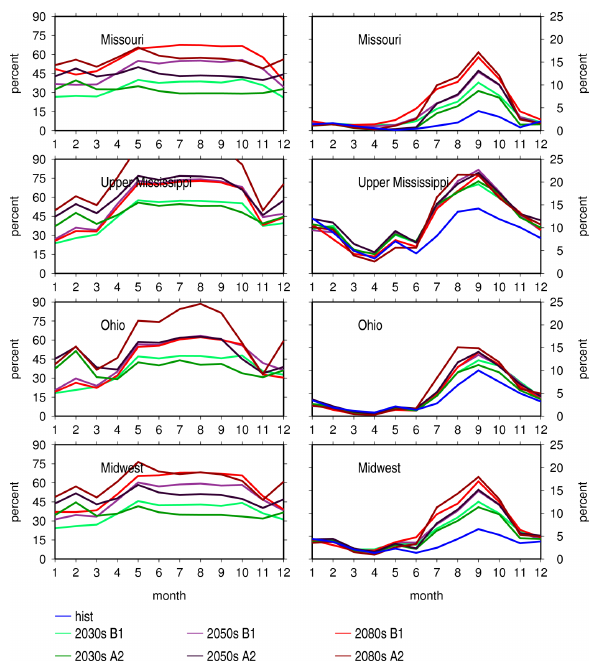
Fig. 9. relative change in total GCAM demand with respect to the historical demand for the three regions (left), and regional mean monthly fractional water supply deficit – or reliance on another wa- ter supply – for historical and future